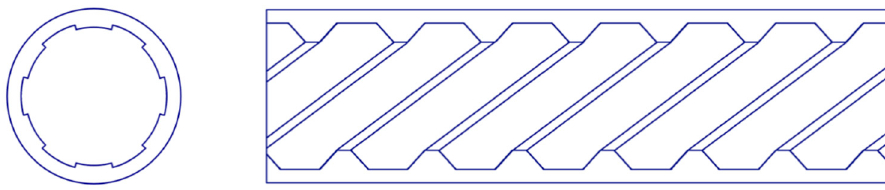
Figure 5. Schematic diagram of the internal spiral-grooved tube.